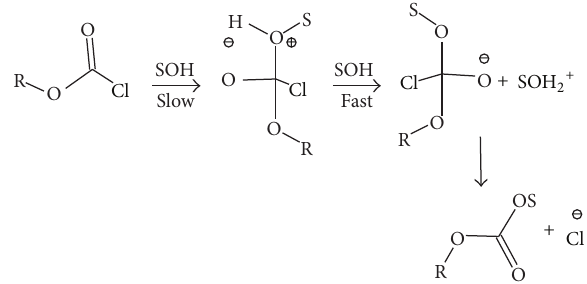
Scheme 1: Stepwise addition-elimination mechanism through a tet- rahedral intermediate for chloroformate